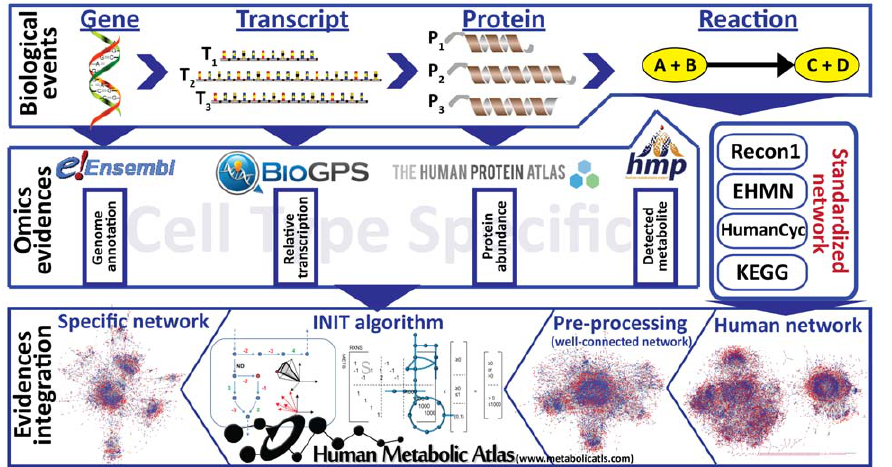
Figure 1. General pipeline used in the reconstruction of cell specific genome-scale metabolic networks. Biological information at the genome, transcriptome, proteome and metabolome levels contained in publicly available databases and generic human GEMs (Recon1, EHMN, HumanCyc) is integrated to form a generic human metabolic network, which is processed in order to obtain the connected iHuman1512 network. Subsequently, the cell type specific evidence is used to generate cell type specific subnetworks using the INIT algorithm.